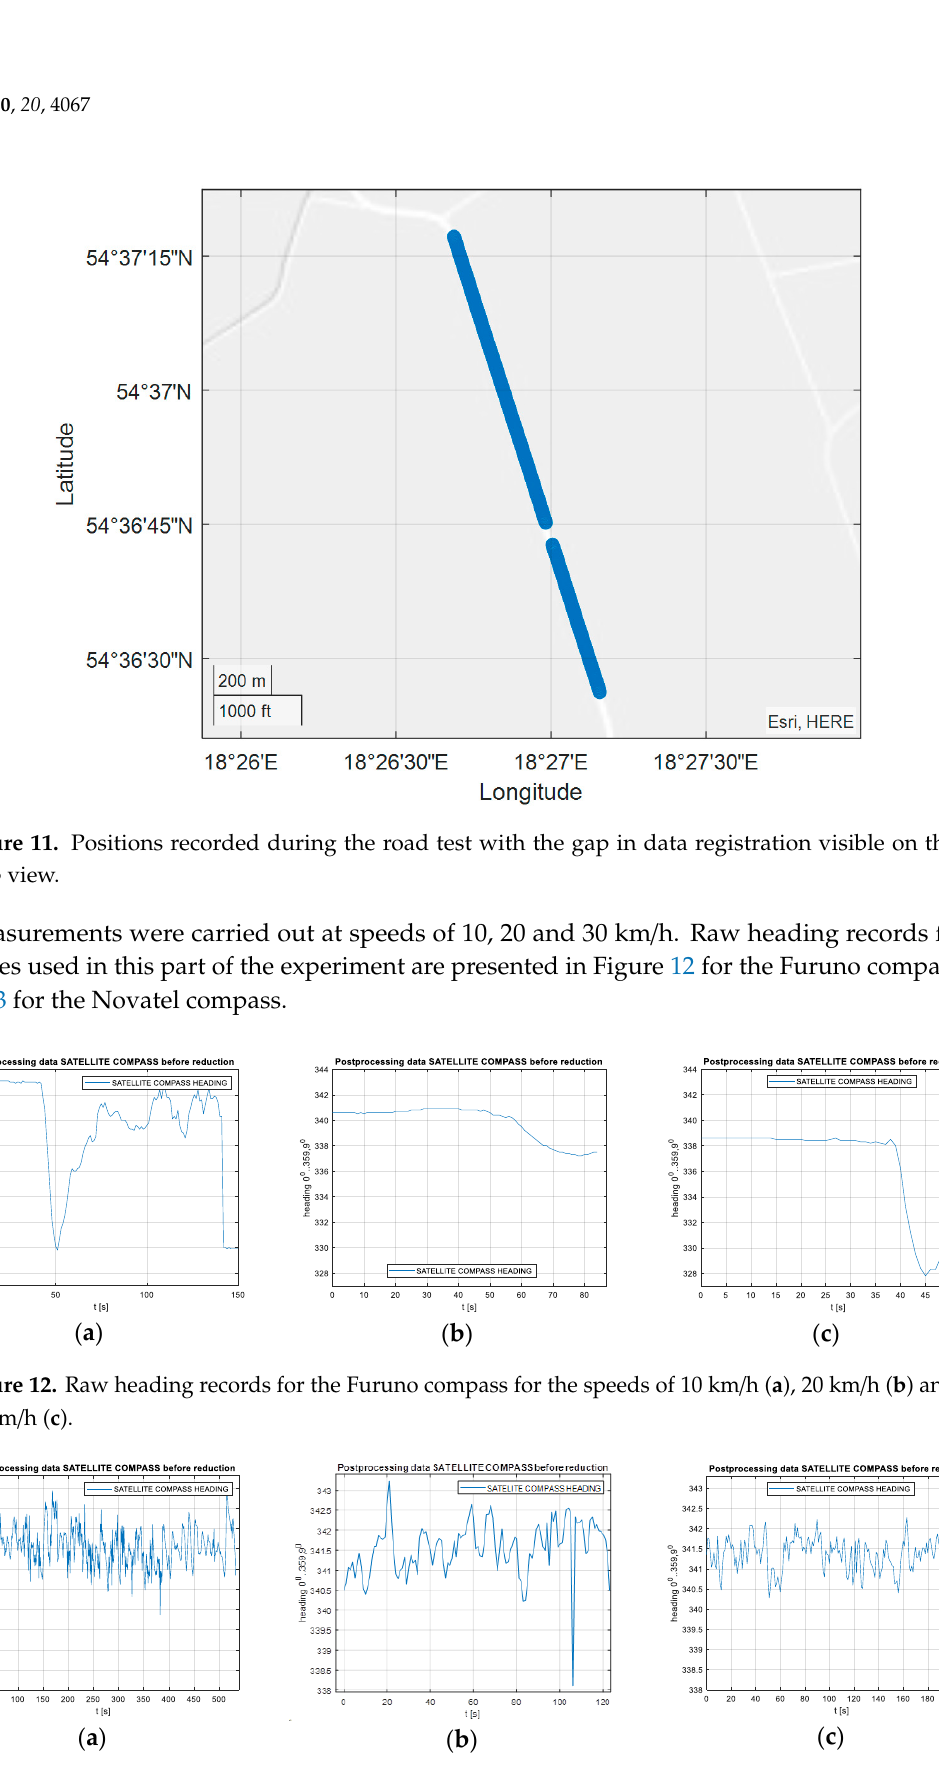
Figure 13. Raw heading records for the Novatel compass for the speeds of 10 km/h ( a ), 20 km/h ( b ) and 30 km/h ( c ).